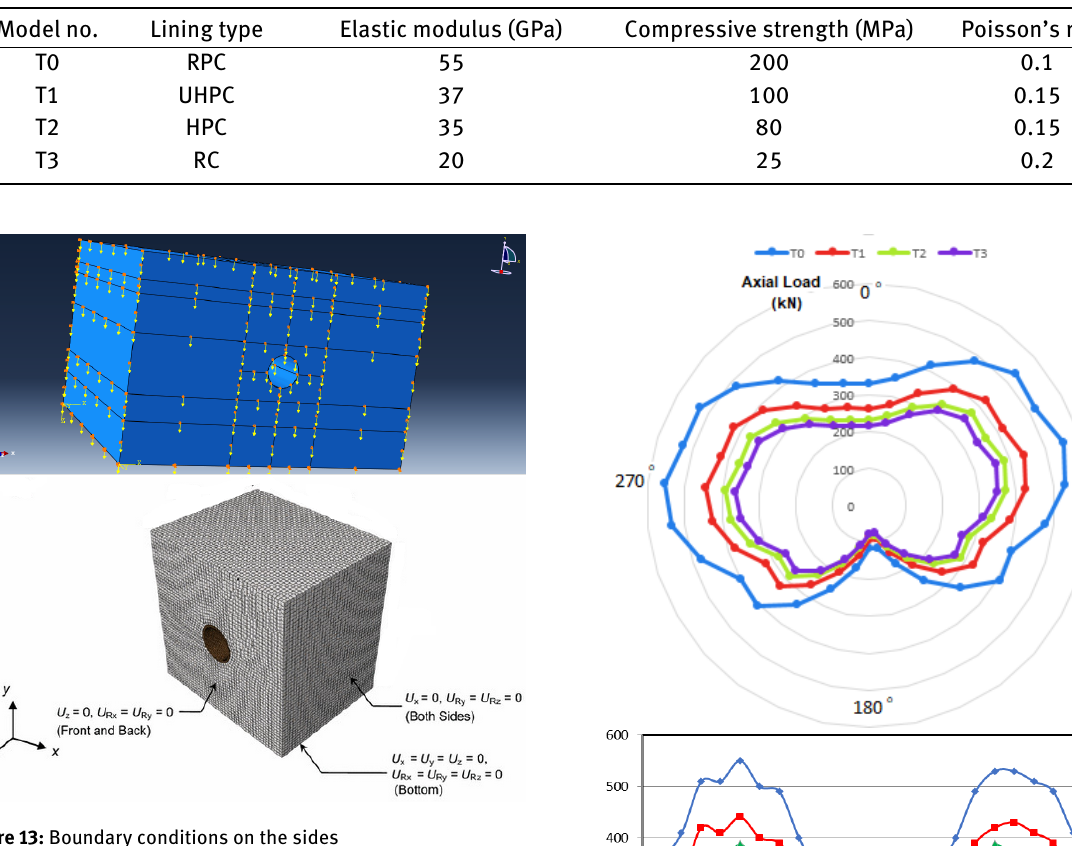
Figure 13: Boundary conditions on the sides